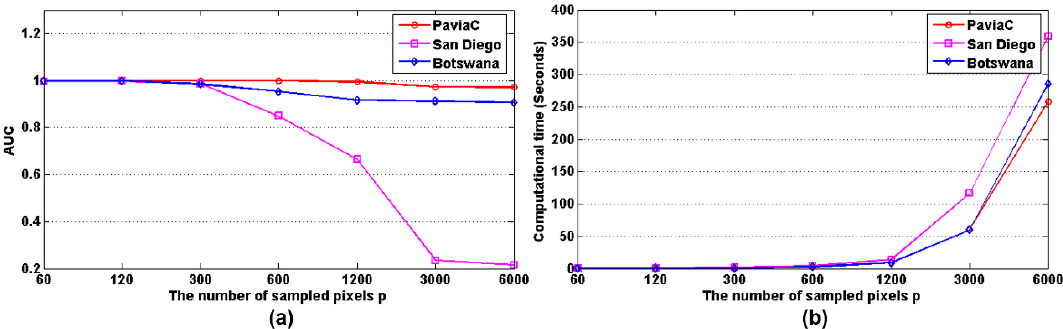
Figure 13. The curves of: ( a ) area under curve (AUC); and ( b ) computation time with different choices of sampled pixels p on the three HSI datasets.